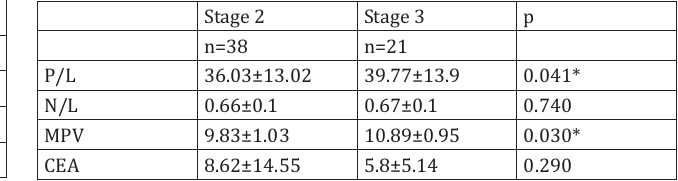
Table 1 Table 2 Mean values of hematological parameters Comparison of parameters between